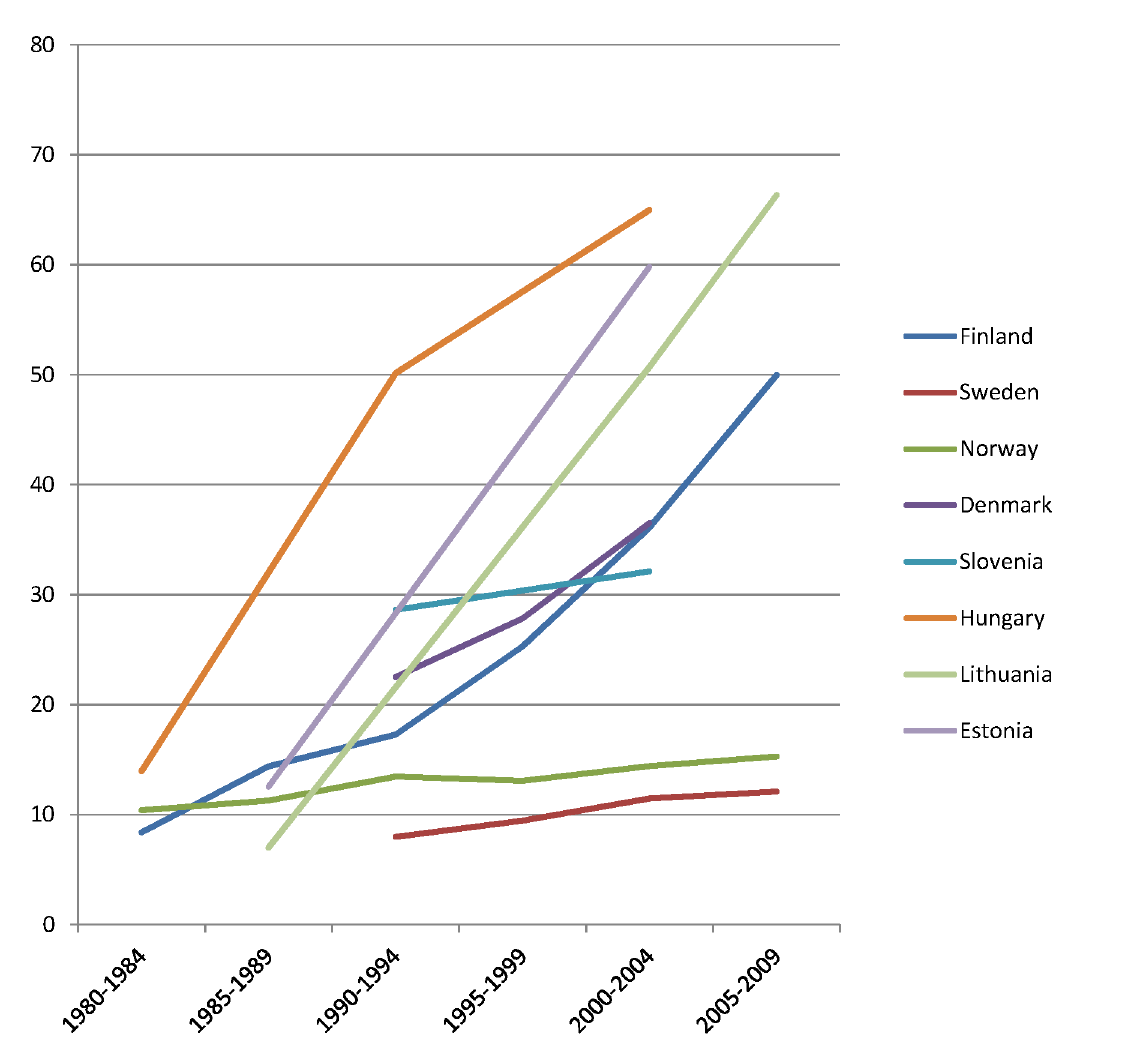
Fig 8. Trends in age-adjusted mortality from alcohol-related causes among women aged 35 – 79 y in the low education group in Northern and Eastern European countries, ca. 1980 – 2010, by country. The y- axis shows age-adjusted alcohol-related mortality in deaths per 100,000